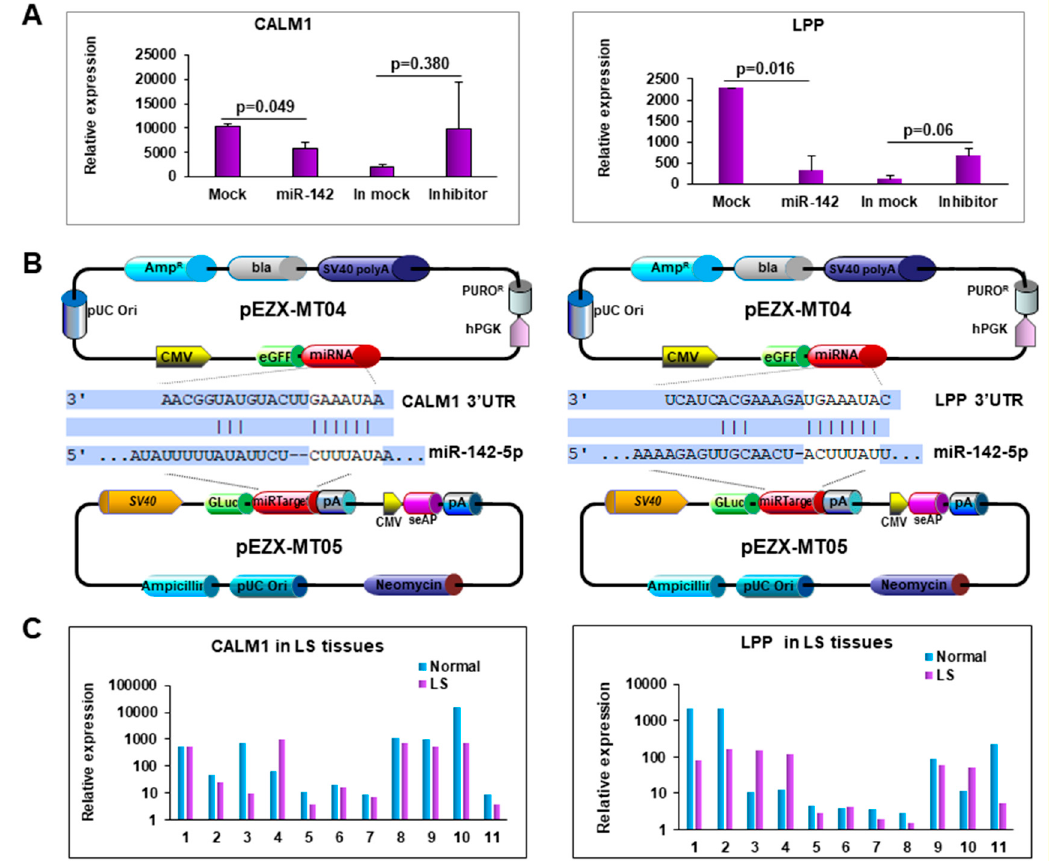
Figure 5. Forced expression of miR-142-5p reduced CALM1 and LPP expression. ( A ) Expression of CALM1 and LPP when miR-142-5p was either overexpressed or knocked-down. ( B ) Map of the plasmids, pEZX-MT04 containing miR-142-5p, and pEZX-MT05 containing 3 ′ -UTR of CALM1 or LPP to illustrate the binding site of miR-1425p to its target genes. ( C ) Expression of CALM1 and LPP in LS tissue.